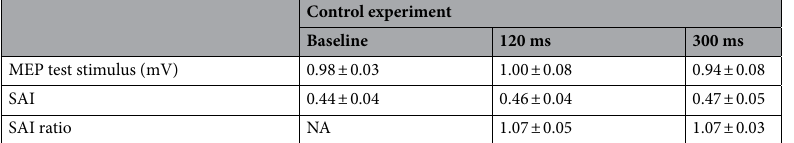
Table 2. MEPs and SAI data in the control experiment. In the table, MEPs values for the test stimulus, SAI data and SAI ratio data are reported for baseline and for the two timepoints considered in the main study (i.e., 120 and 300 ms after stimulus onset). For the SAI ratio data, no baseline is retrievable because it was already used for its computation. All values are reported as mean ± standard error of the mean